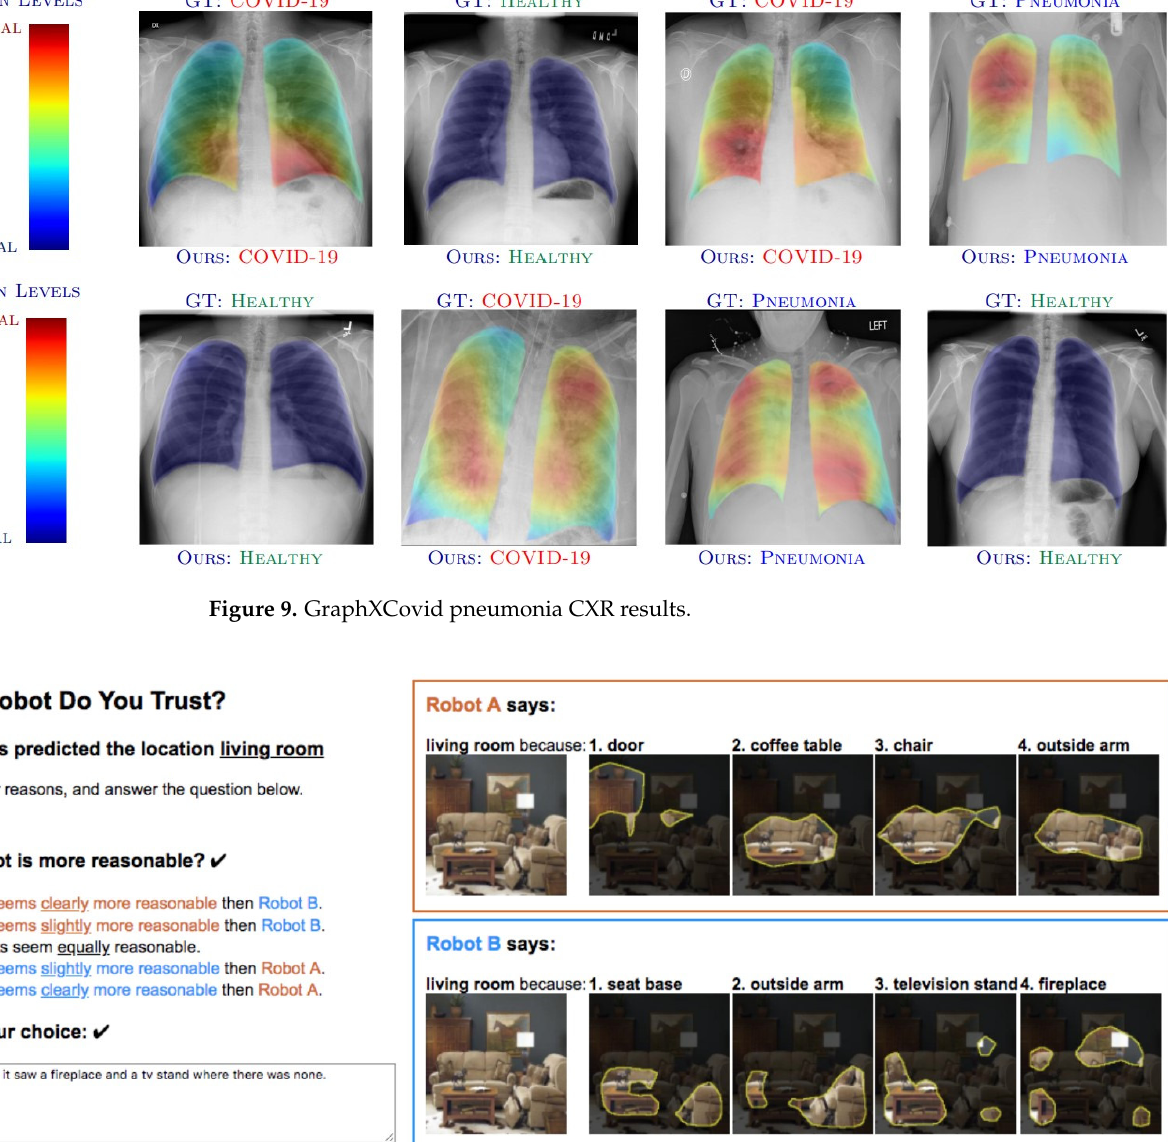
Figure 10. Feedback system for the human rating-based evaluation.